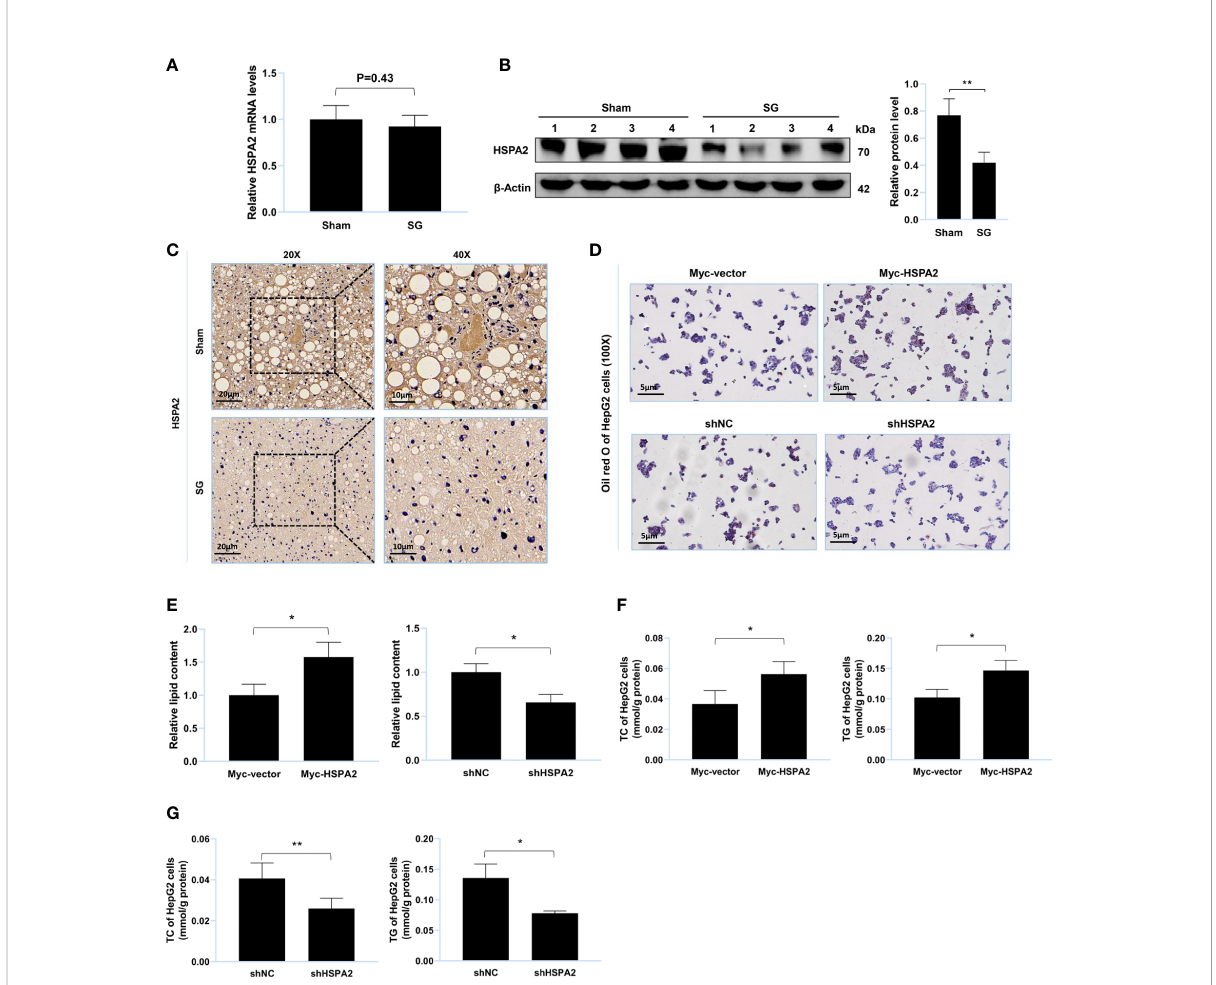
FIGURE 3 HSPA2 promotes lipid accumulation in vitro . (A) Relative mRNA level of HSPA2 in liver from sham group and SG group (n = 4). (B) Western blot detection of HSPA2 in liver from sham group and SG group (n = 4). (C) Immunohistochemistry detection of HSPA2 in liver from sham group and SG group. Scale bars were shown in the fi gure. (D) HepG2 cells were transfected with Myc-HSPA2, Myc-vector, shHSPA2 and shNC. Lipid accumulation of HepG2 cells was assessed by Oil Red O staining. Scale bars were shown in the fi gure. (E) Relative lipid content of HepG2 cells (n = 3). (F, G) TC and TG content of HepG2 cells (n = 3). The data are expressed as mean ± SEM, Student ’ s t-test was used for intergroup comparisons. *p < 0.05, **p <